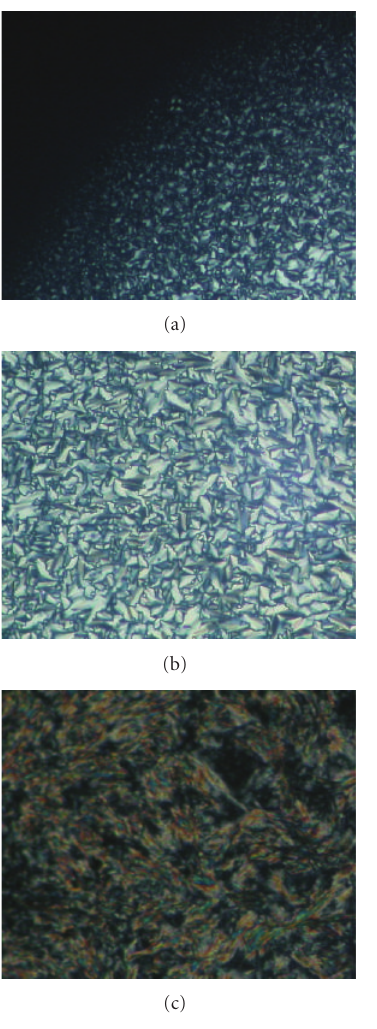
Figure 10: Polarized optical micrographs of cholesteryl benzoate taken during cooling from the isotropic phase at (a) 101.1 ◦ C, (b) 98.8 ◦ C, and (c) 25 ◦ C.